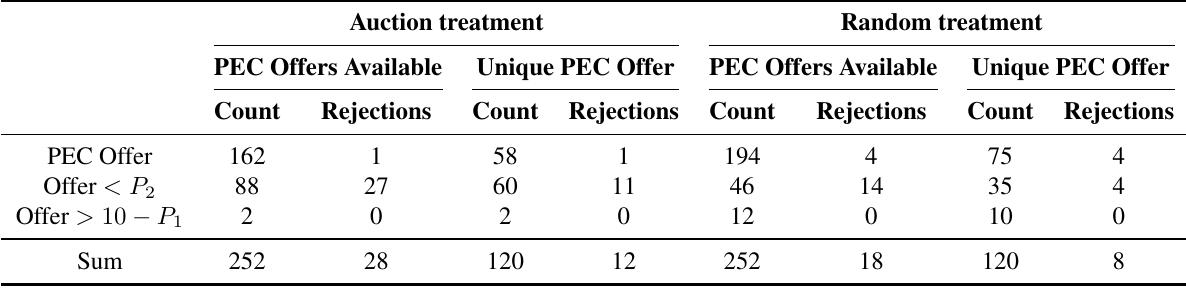
Table 4. Counts of PEC offers, non-PEC offers, and corresponding rejections conditional on P ≤ 10 − P in the 300 stage games of each treatment. 2 1 PEC Offers Available Unique PEC Offer PEC Offers